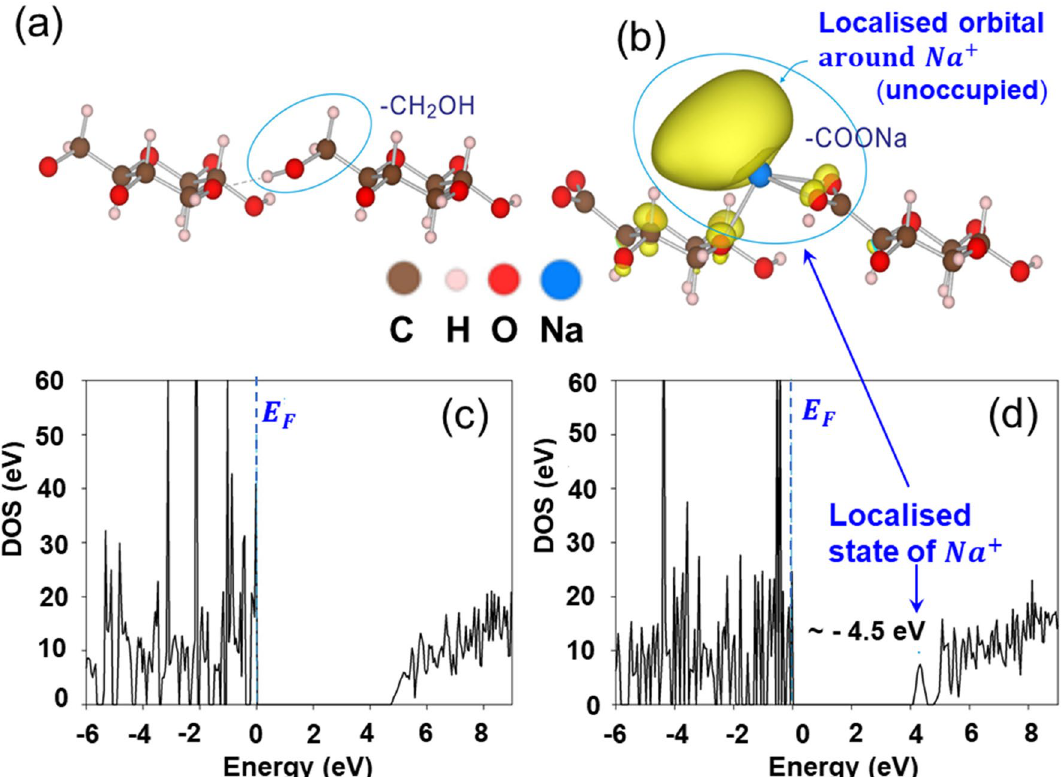
Figure 5. Local structures and density of states (DOS) in C 12 H 20 O 10 and C 12 H 17 O 11 Na. Isolated electronic state (yellow) locally occurs in vicinity of Na